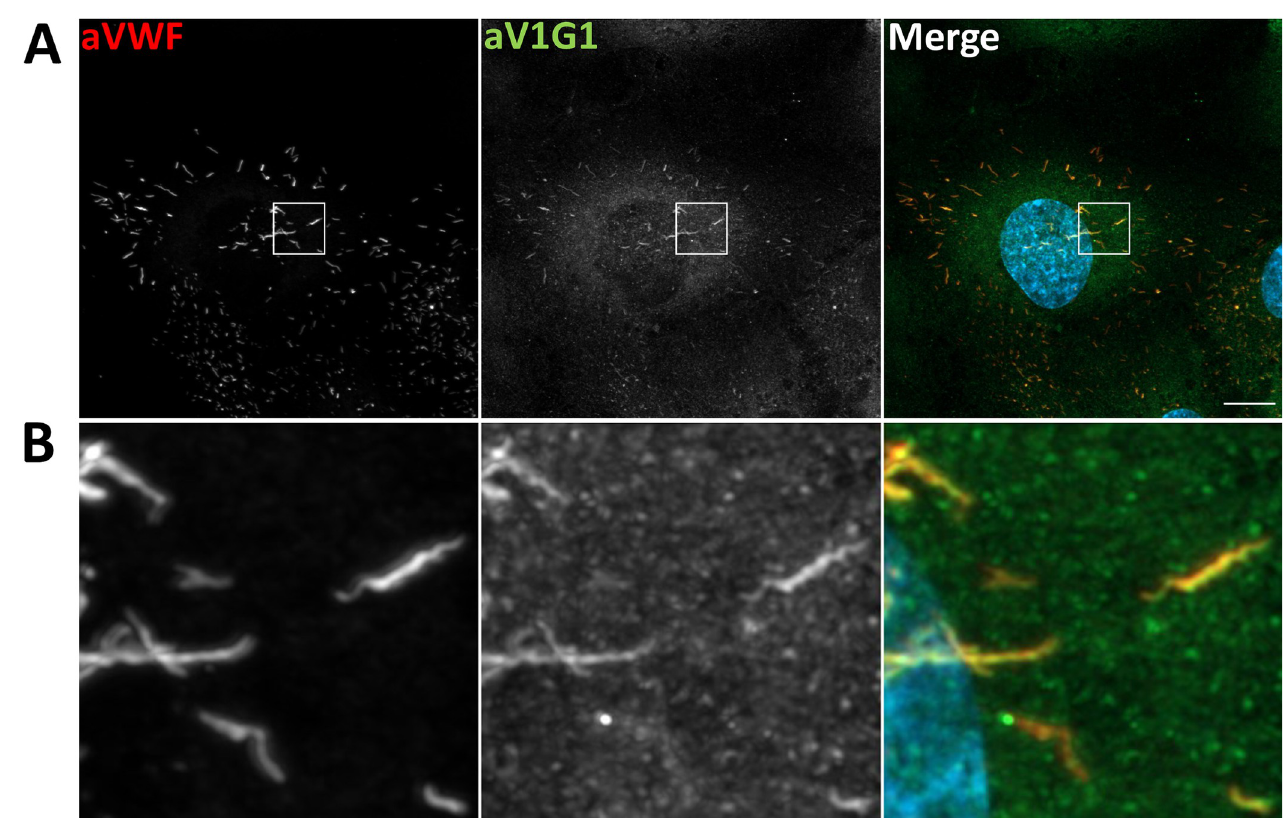
Fig 1. The V-ATPase subunit V1G1 localizes to WPB. A. HUVEC were cultivated on collagen coated coverslips until they reached confluency, then fixed and stained for VWF as a general WPB marker (red) and for ATP6V1G1 (green) using the respective antibodies. Shown are confocal microscope images displaying maximum intensity projections of z-stacks. Boxed area is enlarged in B . DAPI stainings are shown in blue. Scale bars: 10 μ m.